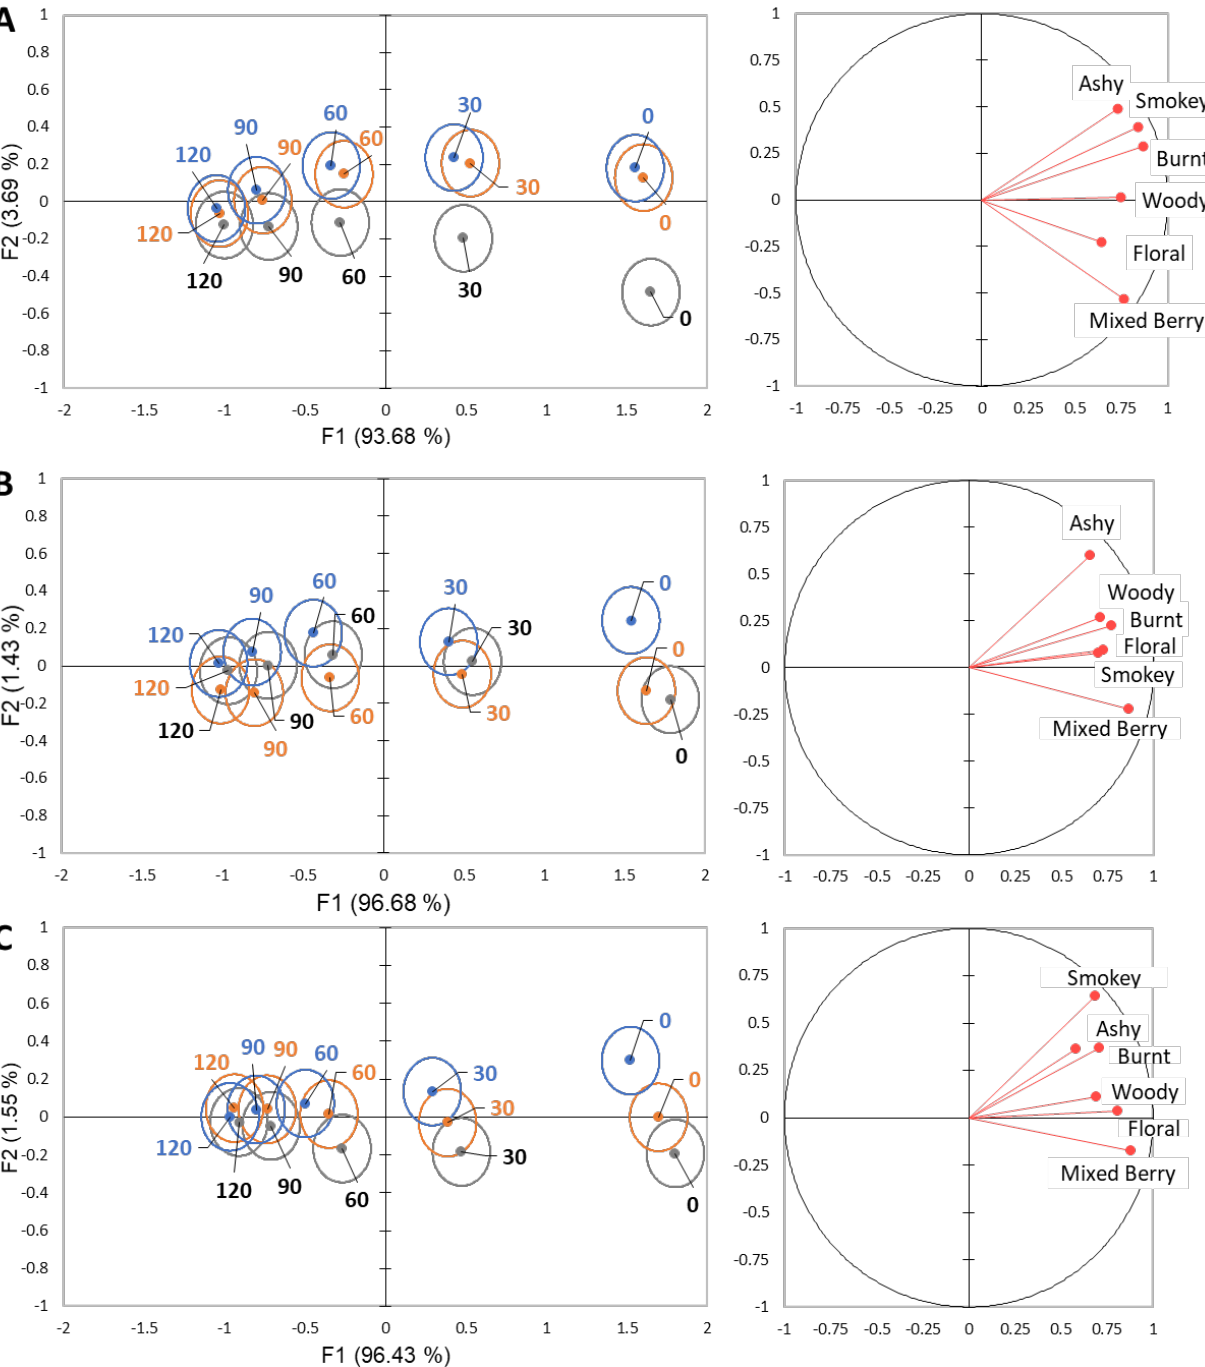
Figure 3. Separation of water (blue), pectin (orange), and mouthwash (grey) rinses in 30 s intervals using DA for each wine; ( A ) high smoke phenol, ( B ) moderate smoke phenol, ( C ) low smoke phenol. Ellipses represent a 95% confidence interval around the means.